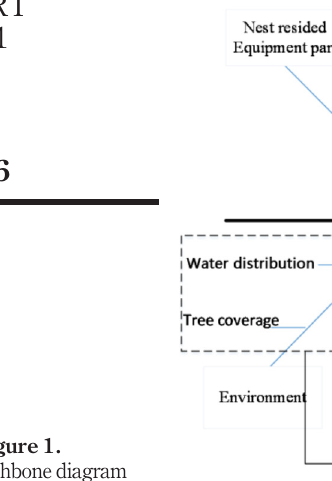
Figure 1. Fishbone